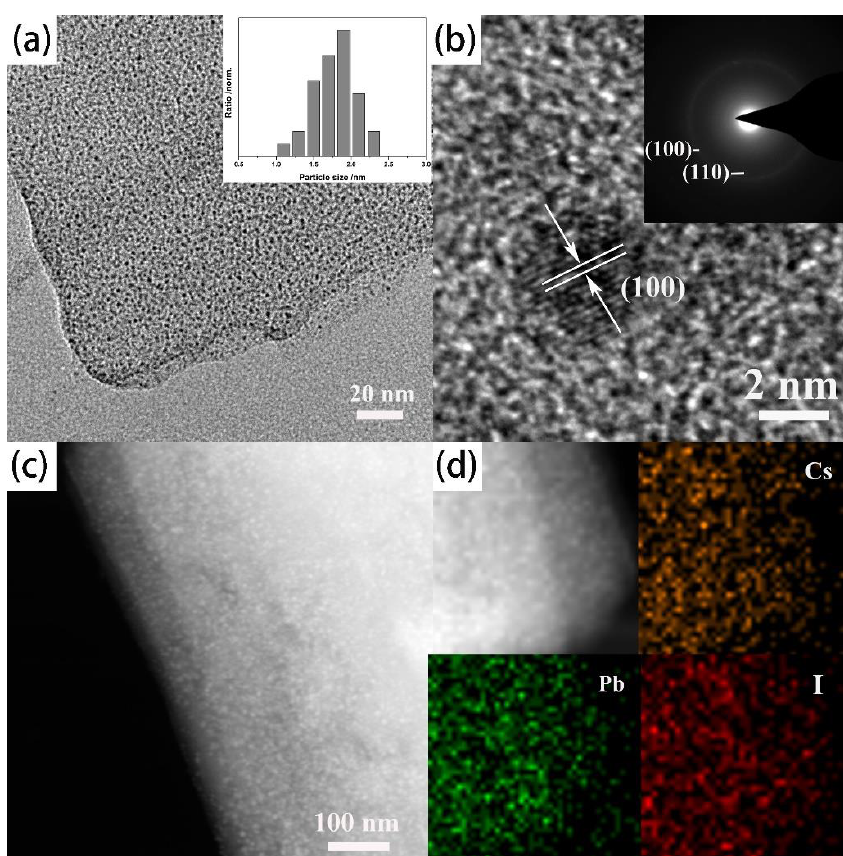
Figure 4. ( a ) The represent TEM image of CsPbI 3 perovskite quantum dots and narrow size distribution insets of figure. ( b ) The HRTEM and SAED images of CsPbI 3 @Cu-BDC ( c ) HAADF-STEM image of CsPbI 3 quantum dots, ( d ) The elemental mapping images showing the elemental distribution of Cs, Pb, and I.